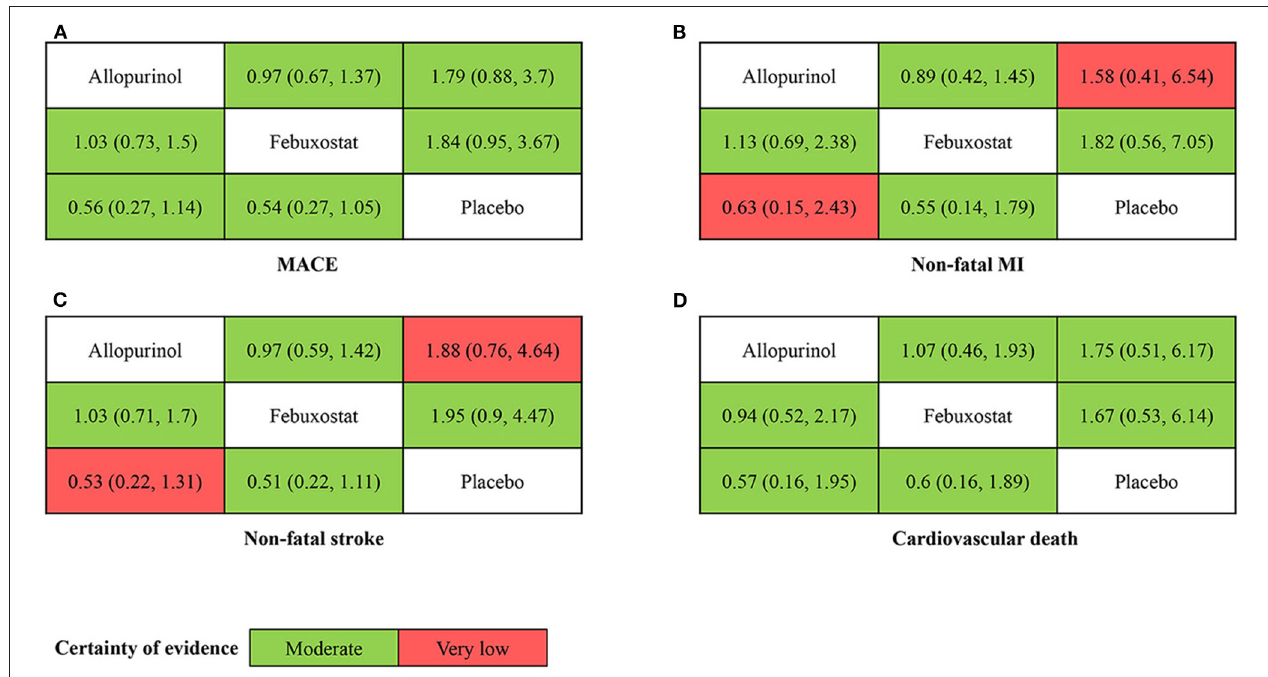
FIGURE 3 | League table of each outcome. Each number is an odds ratio ( = column/row), and 95% confidence interval. Different color represents different certainty of evidence. OR < 1 favors the drug in the column. (A) MACE (major adverse cardiovascular events), (B) non-fatal MI (myocardial infarction), (C) non-fatal stroke, and (D) cardiovascular